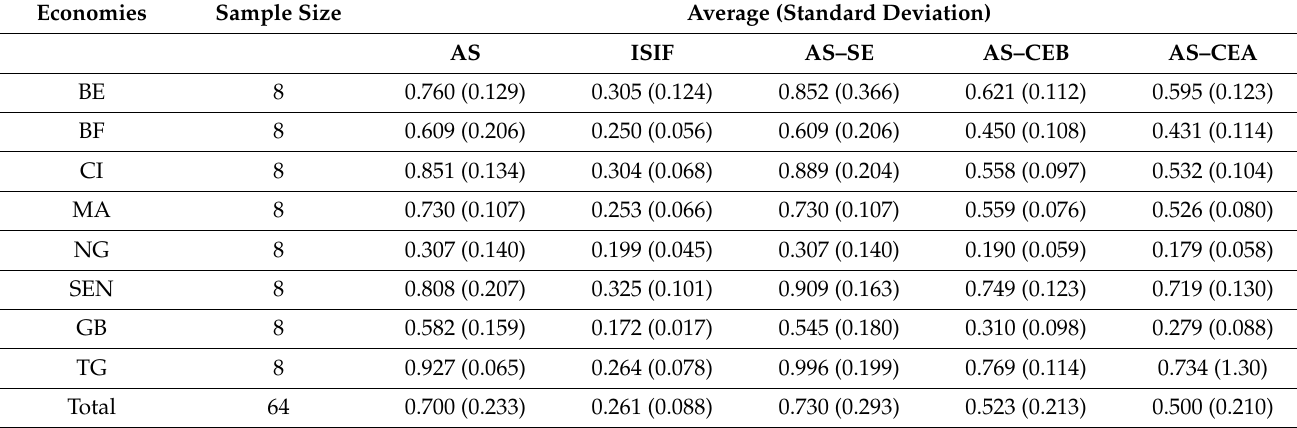
Table 12. All financial inclusion measures by